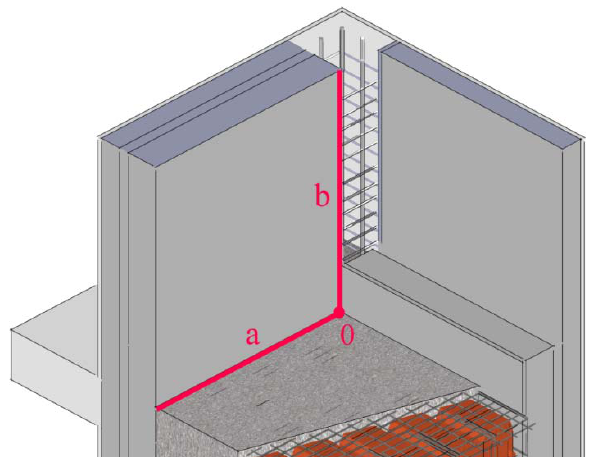
Figure 16. Critical zones for condensation